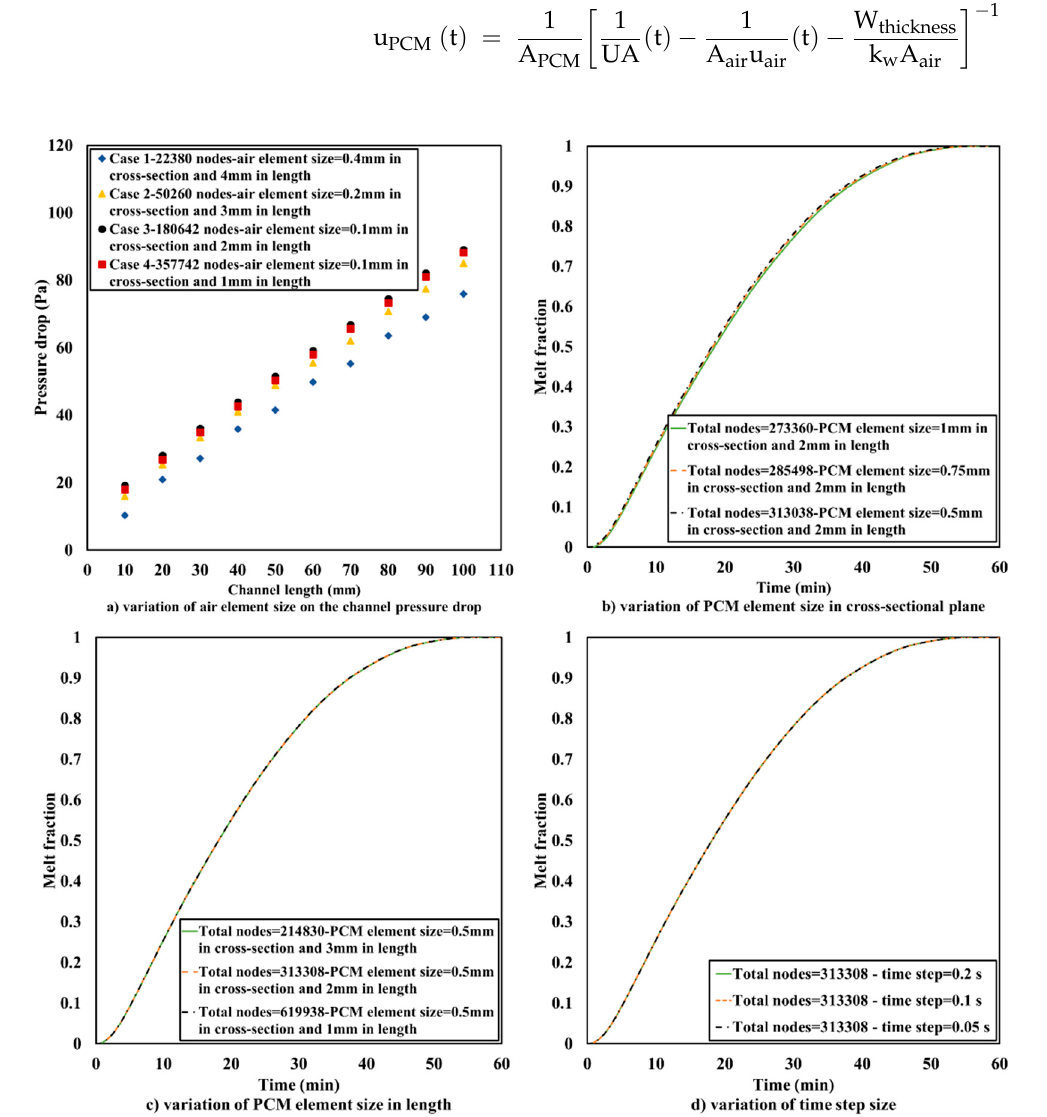
Figure 4. Mesh independency analysis: ( a ) element size variation for pressure drop simulations of air flow in a single channel-2 and V air = 5 m/s, ( b ) element size variation in cross-sectional plane for melt fraction simulations of channel-1 (5 × 16, PF = 82.4%, V air = 10.1 m/s), ( c ) element size variation in length for melt fraction simulations of channel-1 (5 × 16, PF = 82.4%, V air = 10.1 m/s) and ( d ) time-step variation for melt fraction simulations of channel-1 (5 × 16, PF = 82.4%, V air = 10.1 m/s).